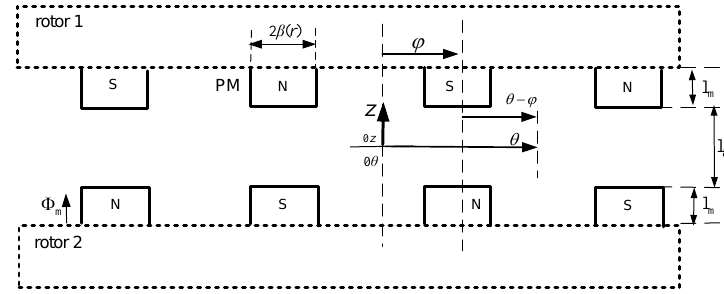
Figure 3. Basic model to illustrate the magnetic field distribution from permanent magnets in the air gap.